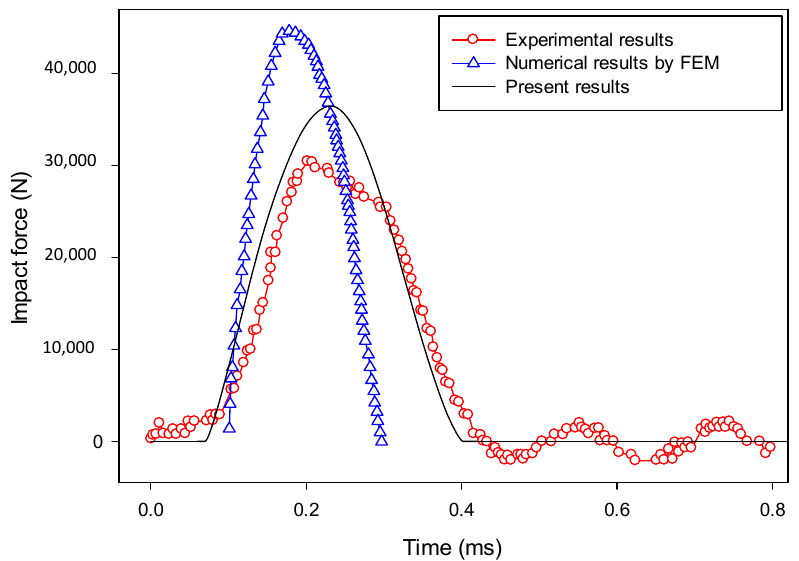
Figure 31. Impact force versus time (impact velocity = 0.881